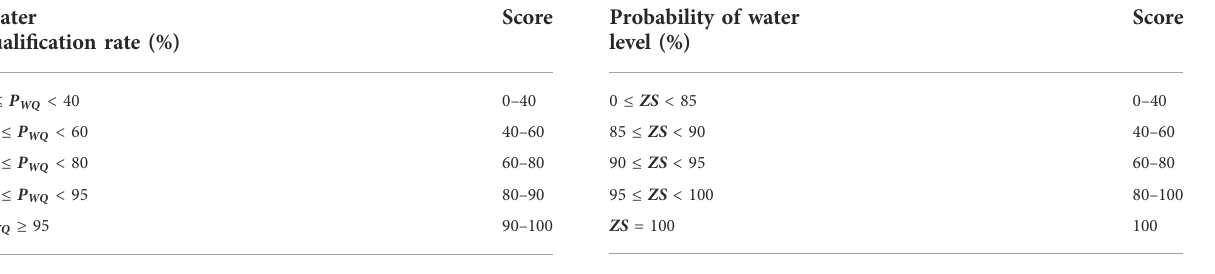
TABLE 4 Index evaluation criteria of the water quali fi cation rate. TABLE 5 Index evaluation criteria of water level